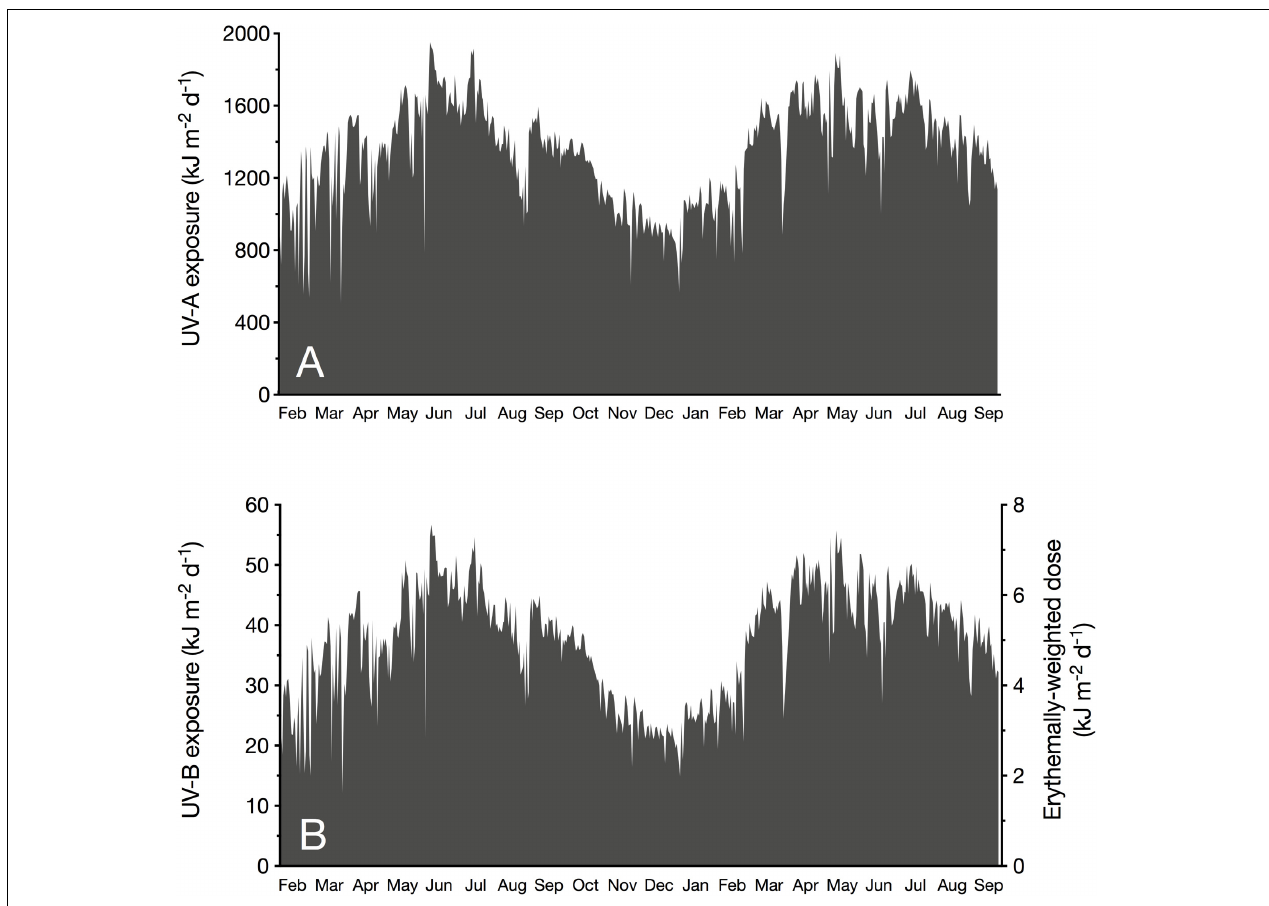
FIGURE 2 | Daily exposure (kJ m - 2 d - 1 ) of incident unweighted UV-A (315–400 nm; A ) and UV-B (280–315 nm; B , left y -axis) radiation, and erythemally weighted UV doses ( B , right y -axis). Values were measured at sea level at the KAUST CMOR pier (22.304639 ◦ N, 39.102167 ◦ E) between February 2017 and September 2018.